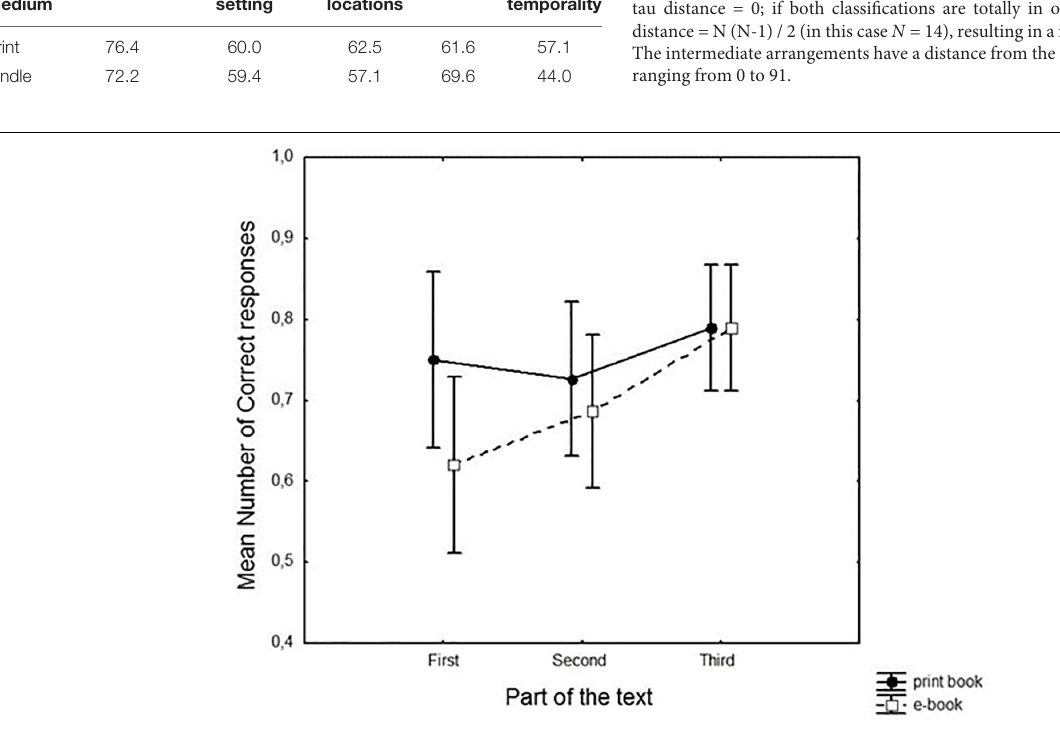
TABLE 3 | Factual Recall Questionnaire: Rate of correct responses (%). Reading Characters Geographical medium setting